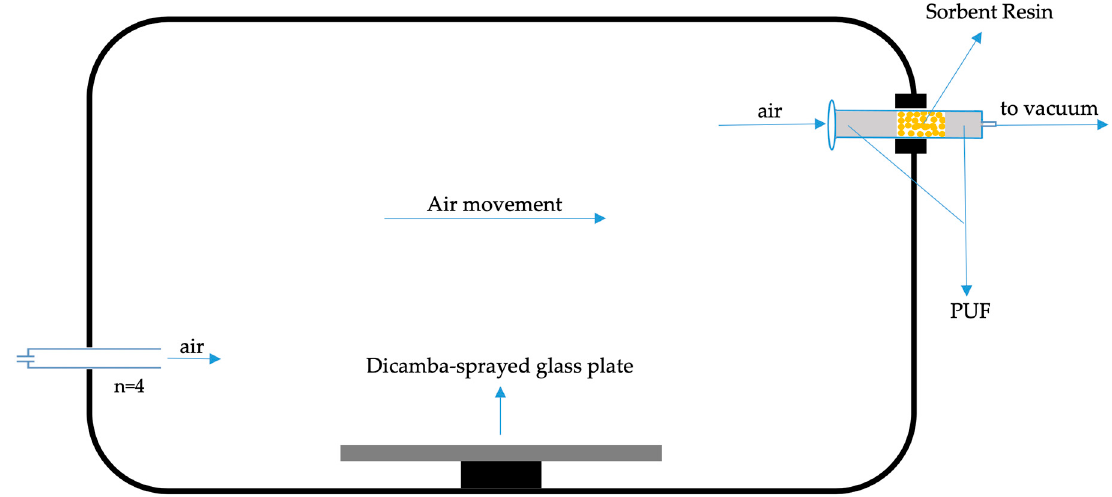
Figure 4. Schematic diagram of the vapor chamber (side view) used in the experiment .